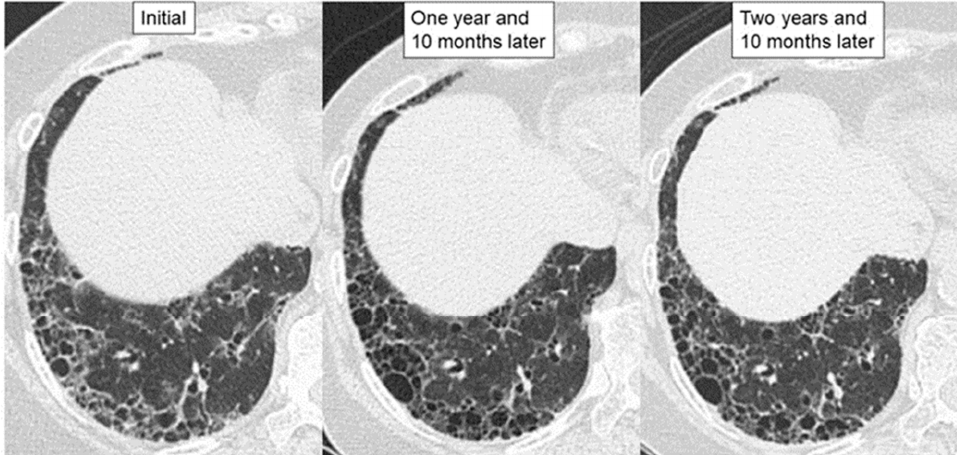
Figure 3. High-resolution computed tomographic images of a patient with a stable course of MPA- ILD with UIP pattern for less than 3 years. The patient received anti-inflammatory therapies, after which wall thickening in the areas of honeycombing had improved, and the fibrotic lesion did not extend without requiring administration of an anti-fibrotic agent.